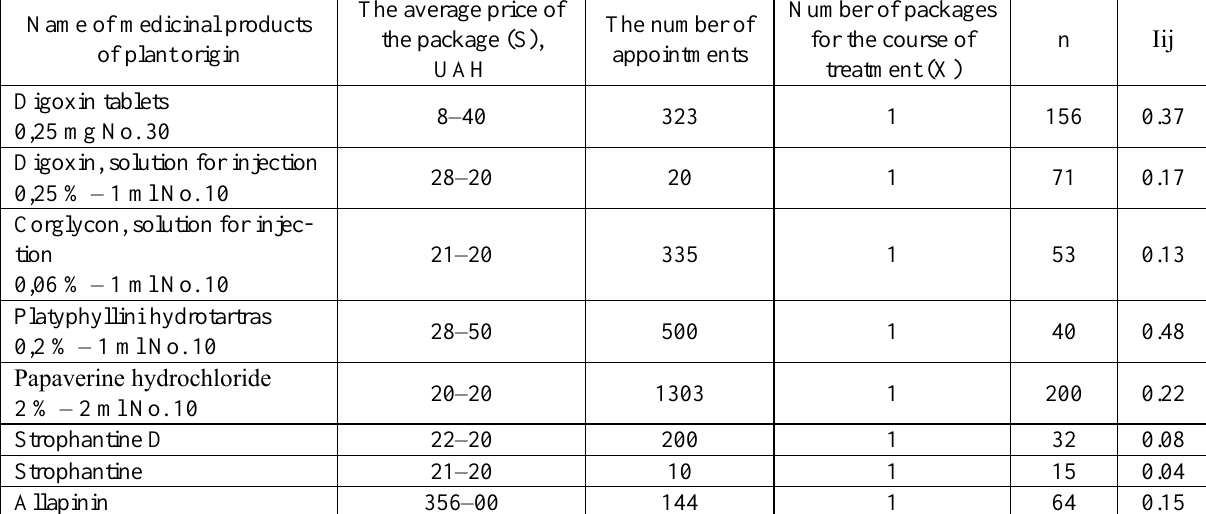
Analysis of the frequency of medicinal products of plant origin for the treatment of cardiovascular disease